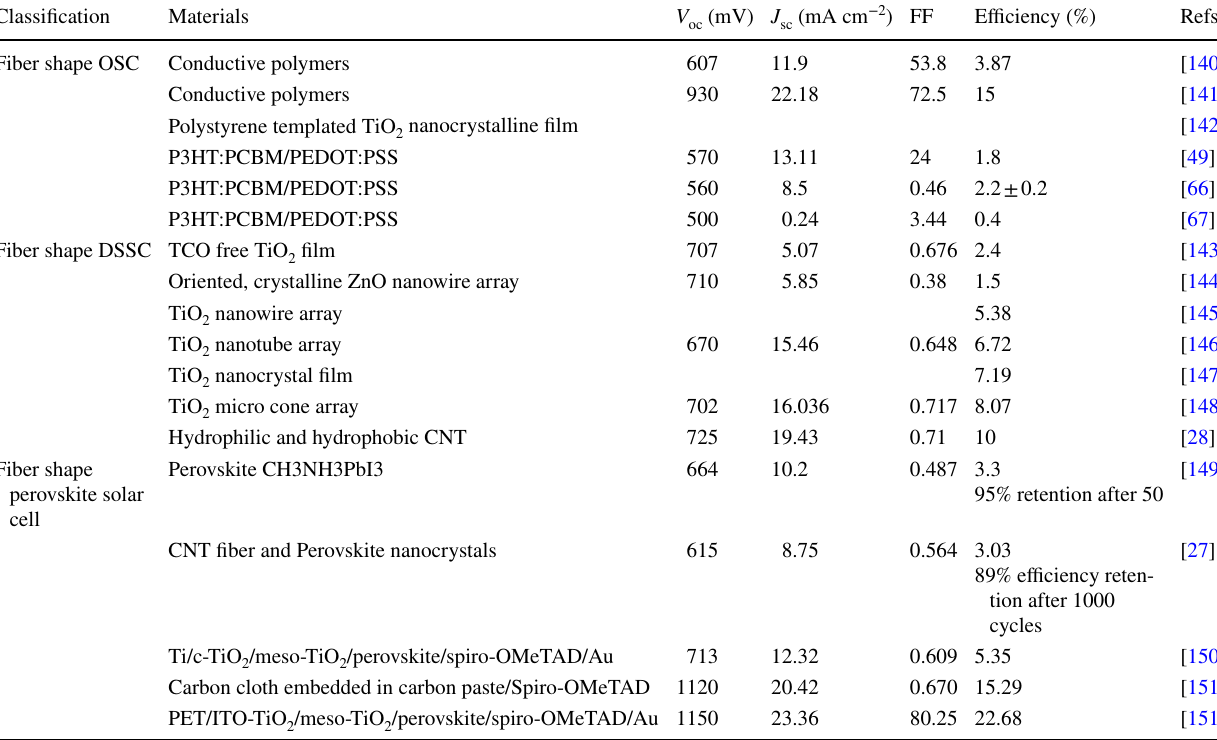
Table 1 Performance of textile-based energy harvesting devices